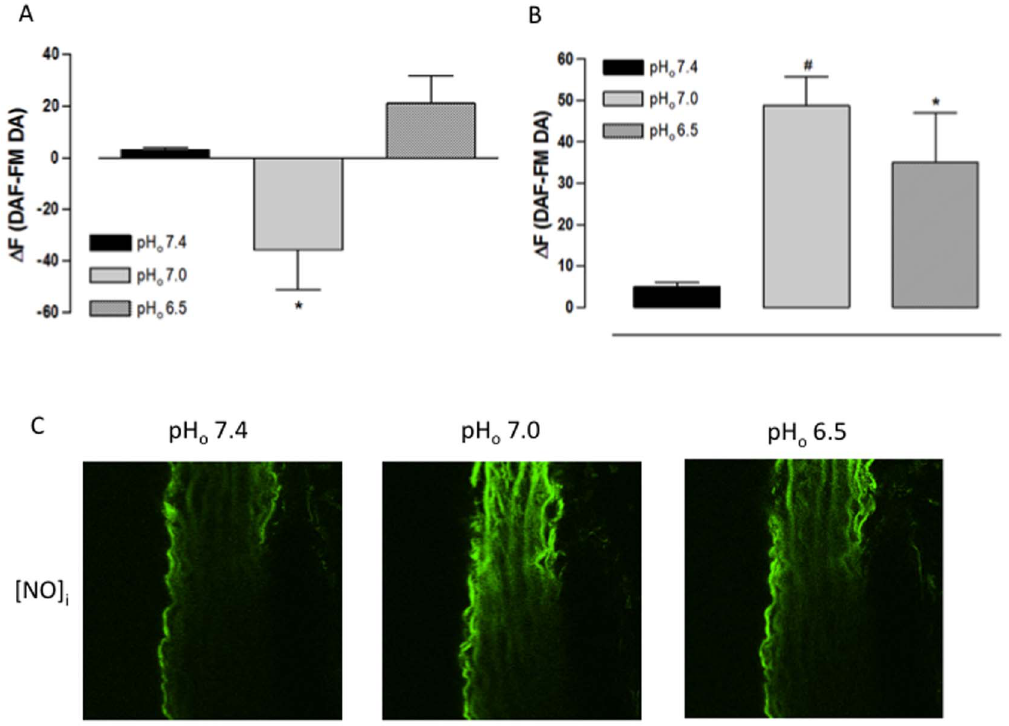
Figure 6. Effect of extracellular acidification on [NO] i of rat aorta cross sections assessed using a confocal scanning laser microscope. A) Fluorescence intensity for endothelial layer. B) Fluorescence intensity for muscular layer. C) Representative confocal photomicrograph of one aorta cross section. Aorta cross sections were loaded with DAF-FM DA (5 m M) and analyzed by confocal microscopy. Aorta cross sections were stimulated at 3 rd and 9 th min with Hanks acidified solution pH 7.0 and 6.5, respectively. HCl was used to change the pH of Hanks solution; Hanks solution pH 7.4 served as control. Fluorescence intensity was measured before the stimulus (F) and at 6 th min after the stimulus for each pH o value (F pH ). Results are reported as D F=F pH – F. All values are means 6 SEM (n=7). One-way ANOVA, Bonferroni’s post-test, * p , 0.05 versus control, # p , 0.001 versus control.